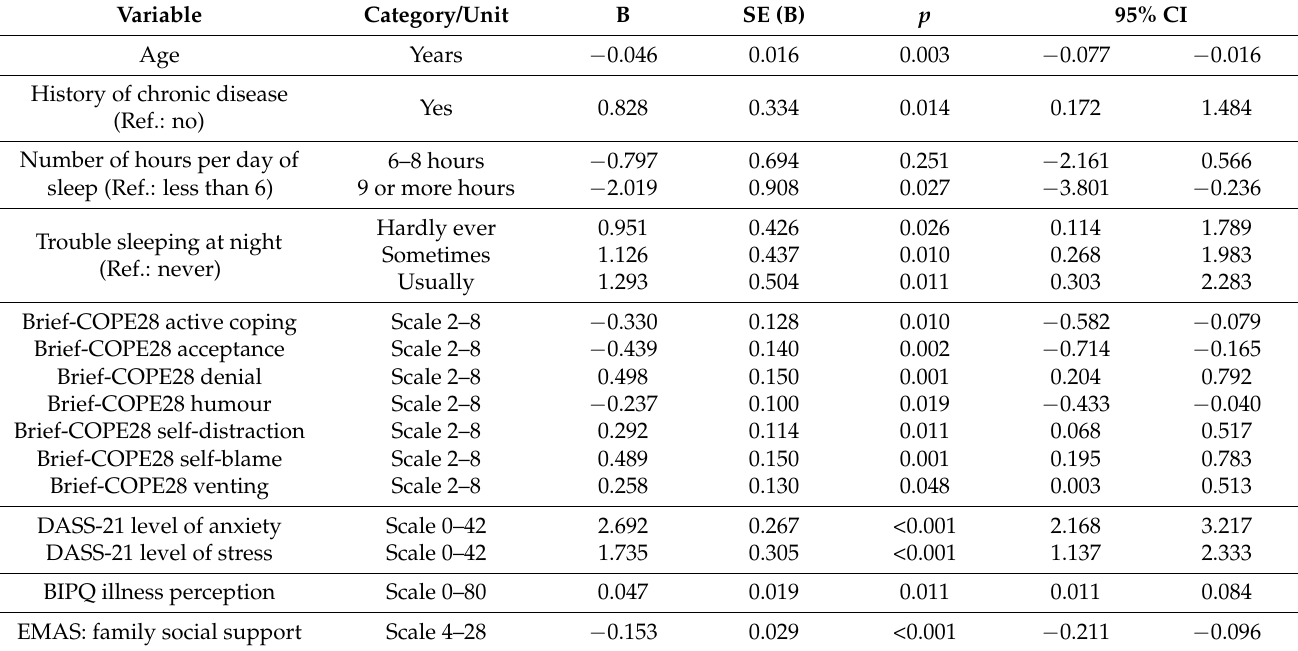
Table 3. Factors related to depression scores. Linear regression model.